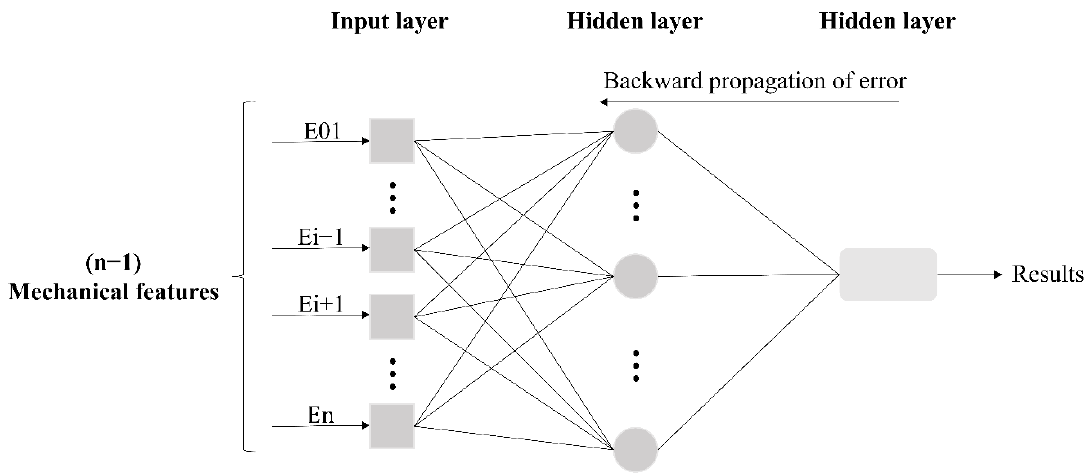
Figure 2. The intelligent analysis of a BPNN in the correlation of mechanical properties of multiple measuring points of valve hall members.